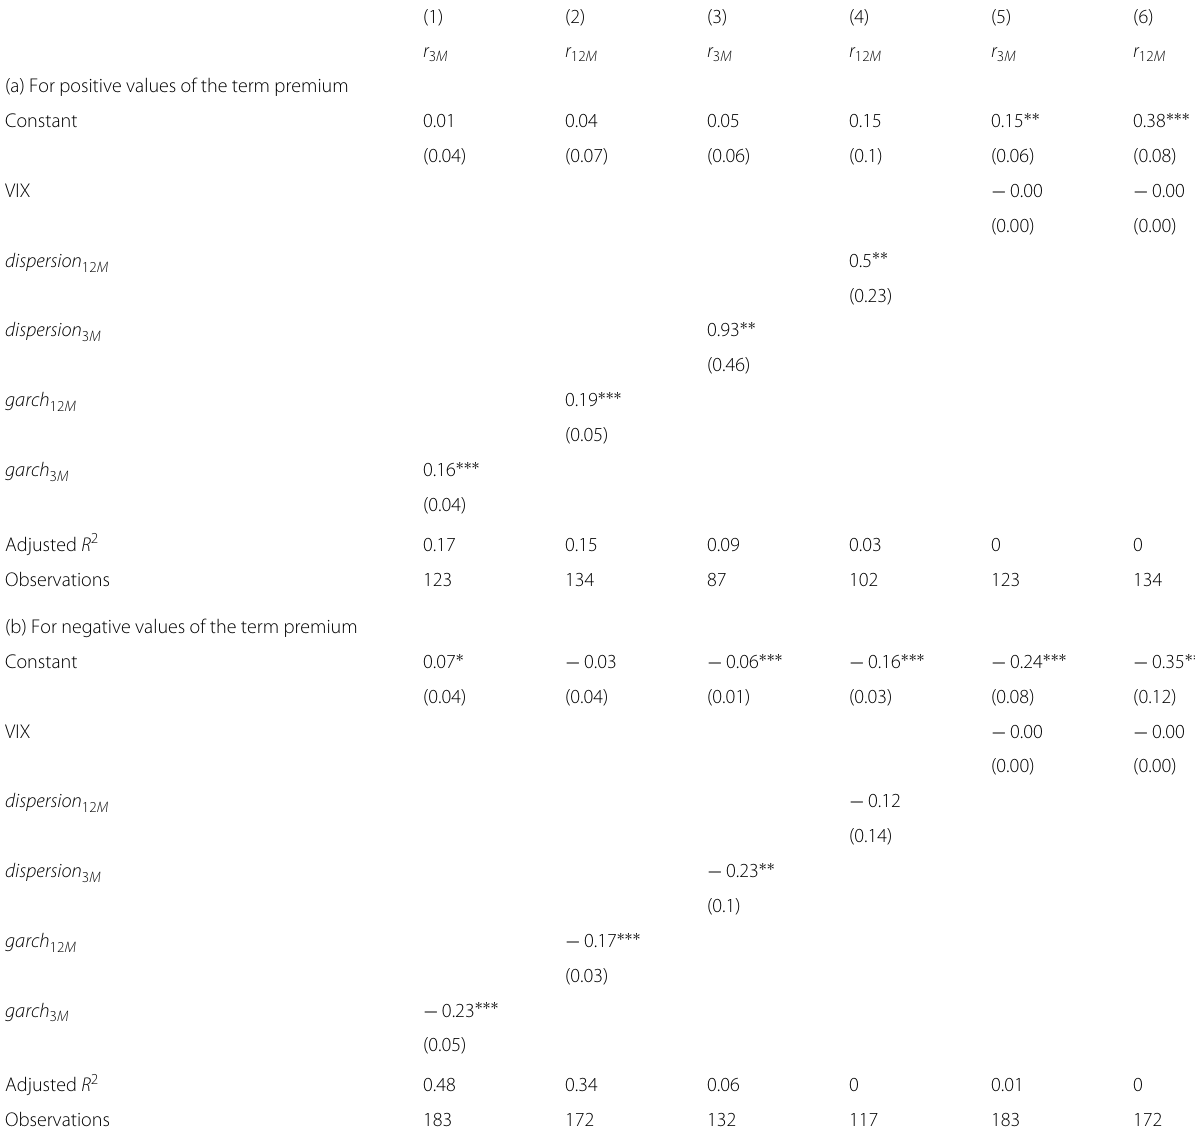
Table 6 Uncertainty and the size of the absolute term premium for positive and negative values